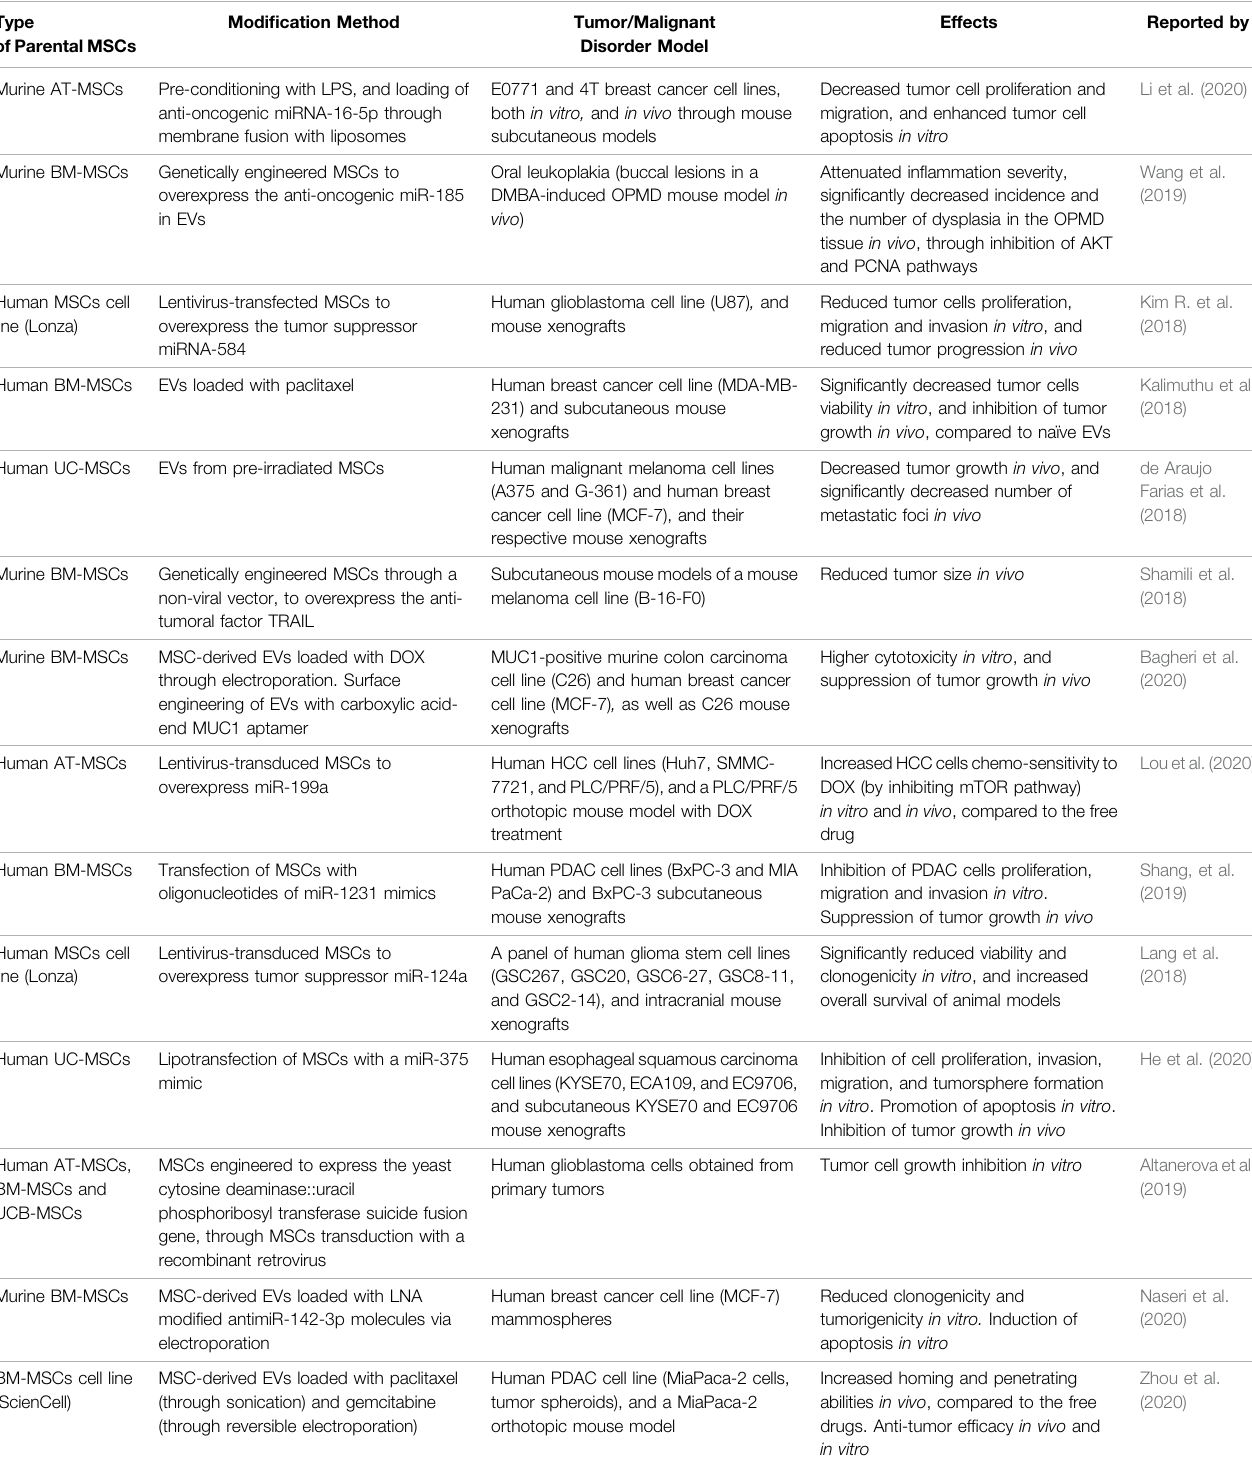
TABLE 1 | Pre-clinical data from the 2018-2021 period, regarding extracellular vesicles evaluation as drug delivery systems for cancer therapy. Abbreviations: AT-MSCs: adipose-tissue mesenchymal stem cells; BM-MSCs: bone-marrow MSCs; DMBA: 7,12-dimethylbenzathracene; DOX: doxorubicin; EVs: extracellular vesicles; GRP78: glucose-regulated protein 78; HCC: hepatocellular carcinoma; LNA: locked nucleic acid; LPS: lipopolysaccharide; MUC1: mucin 1 cell surface-associated; NSCLC: non- small cell lung cancer; OPMD: oculopharyngeal muscular dystrophy; PCNA: proliferating cell nuclear antigen; PDAC: pancreatic ductal adenocarcinoma; TRAIL: tumor necrosis factor-related apoptosis-inducing